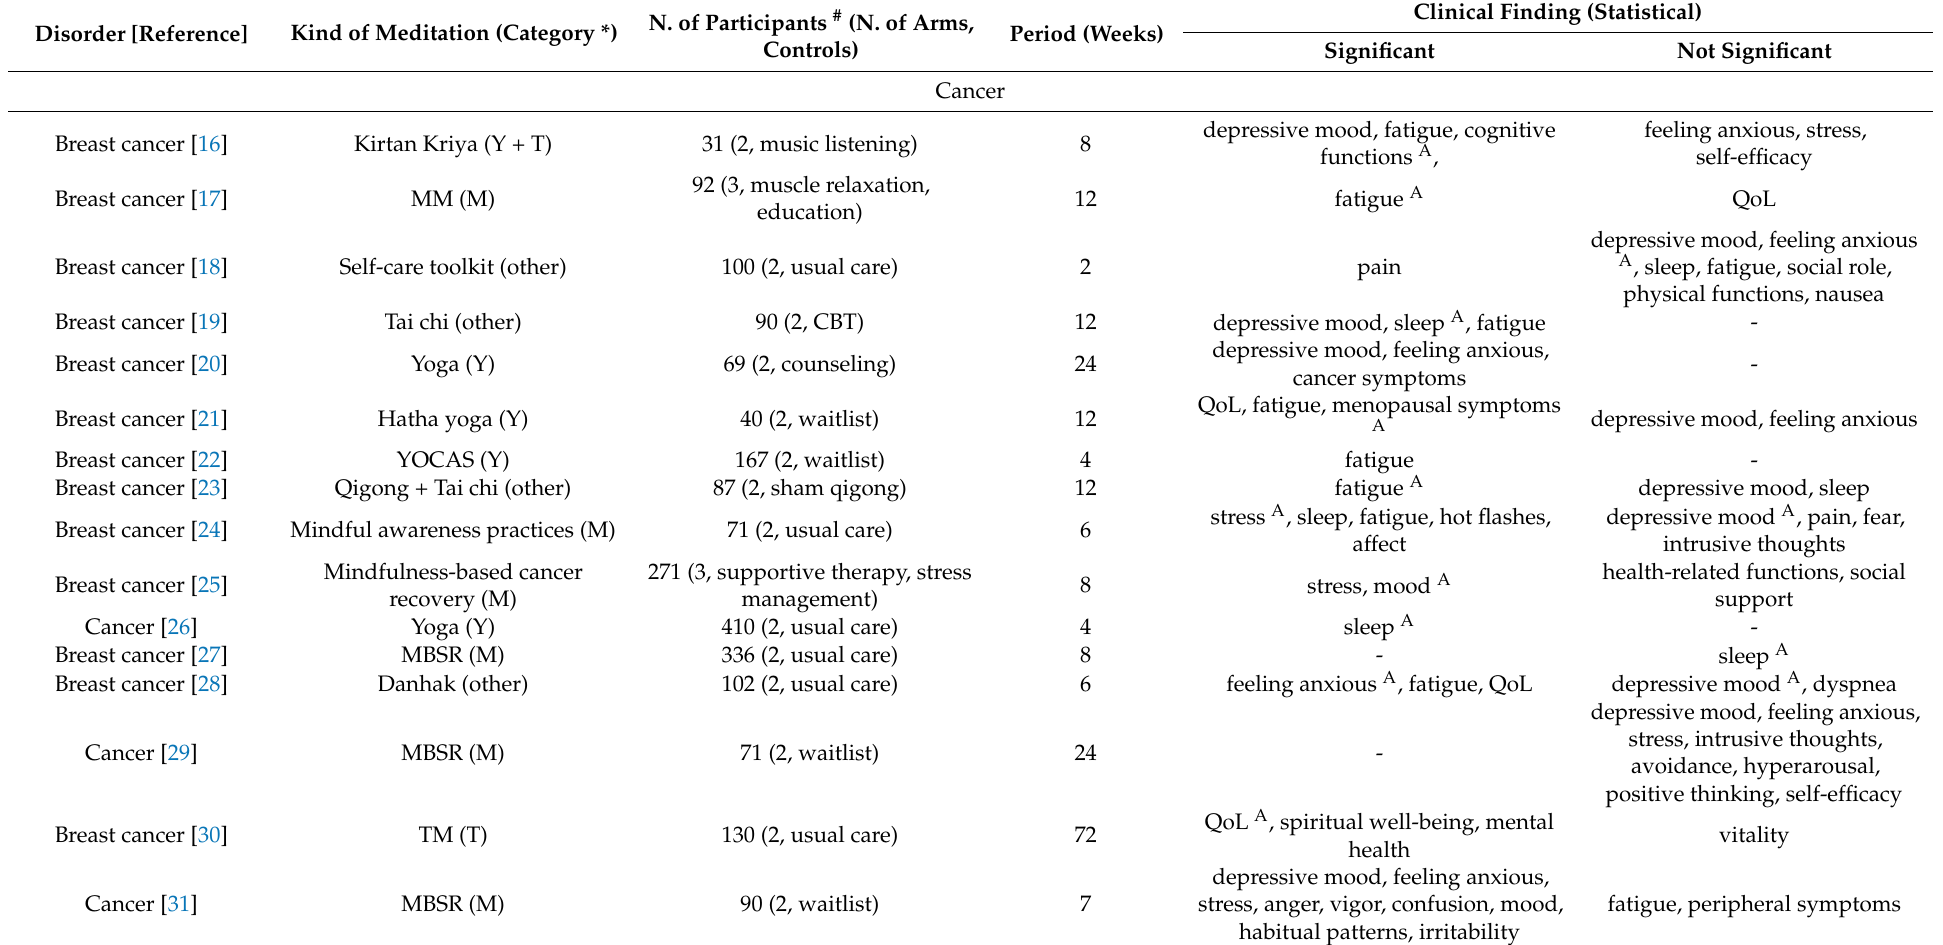
Table 2. Summary of the RCTs for participants with physical